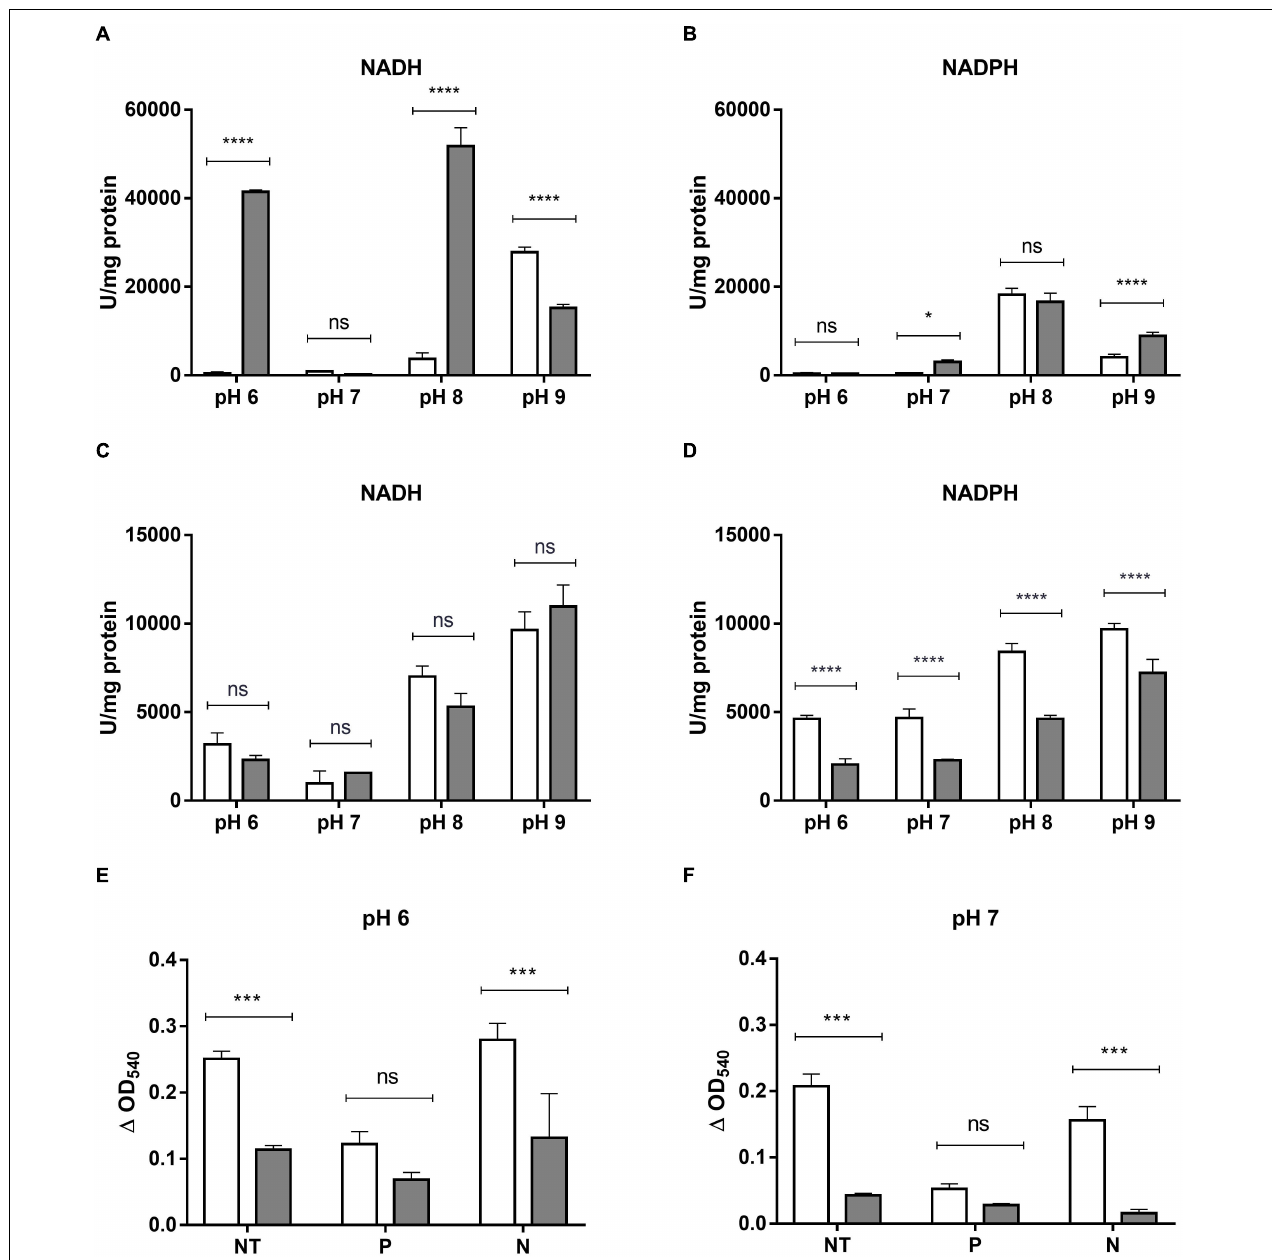
FIGURE 4 | HAuCl 4 and K 2 TeO 3 reducing activity by crude extracts or EPS from E. cloacae MF01. HAuCl 4 (A,B) - or K 2 TeO 3 (C,D) -reducing activity by crude extracts of E. cloacae MF01 was assessed either with NADH or NADPH, at pH values 6.0, 7.0, 8.0 and 9.0, under aerobic (white bars) and anaerobic conditions (gray bars). Assays for HAuCl 4 -reducing activity mediated by EPS (E,F) were carried out using samples without treatment (NT) and with previous protease (P) or nuclease (N) treatments, at the indicated pH values and under aerobic (white bars) or anaerobic conditions (gray bars). Bars represent the average of three independent tests ± SD. ∗ p < 0.05; ∗∗∗ p < 0.0002; ∗∗∗∗ p < 0.0001; ns, no